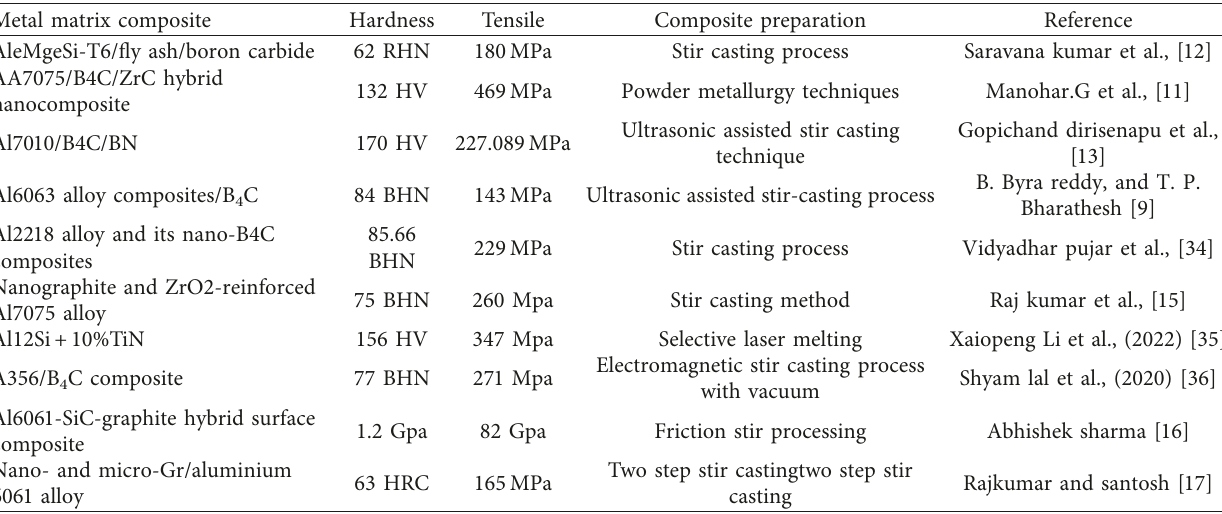
Figure 7. The microtension was habitual in any appear- ance at atmospheric temperature, particularly the methods of determination of yield strength, yield point, elongation, tensile strength, and reduction of area. The multiuse microtensile testing machine amid submissive seize is utilized to hold the tensile specimen as shown in Figure 8. Increased reinforcing enhanced the composites ulti- mate tensile strength and stress-strain, as shown in Fig- ure 9. Table 3 shows the variation in ultimate tensile strength with AMMCs. The B Cnp and Grnp reinforce- 4 ment’s load value has been enhanced. The maximal ulti- mate tensile strengths are 668.93 MPa and 739.16 MPa,